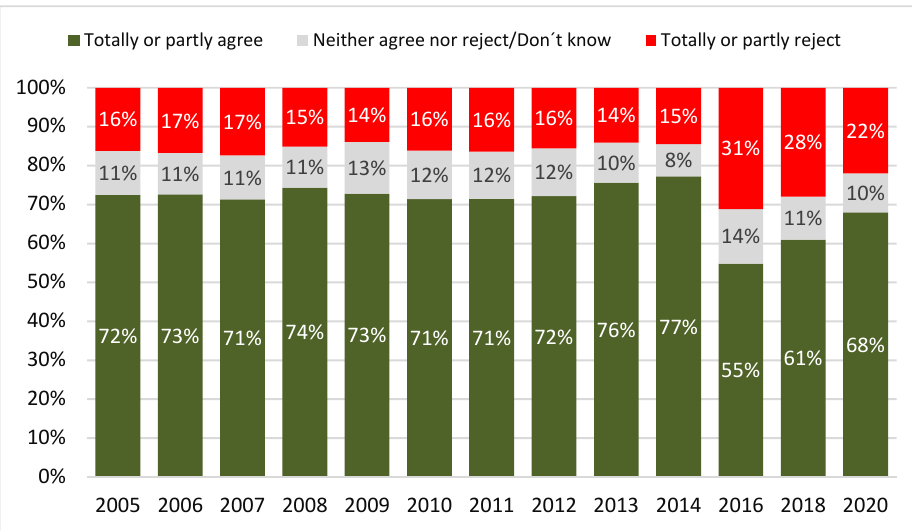
Figure 7. Positive statement about equal social rights: All people with foreign background who come to Sweden must have the same social rights as Swedes.